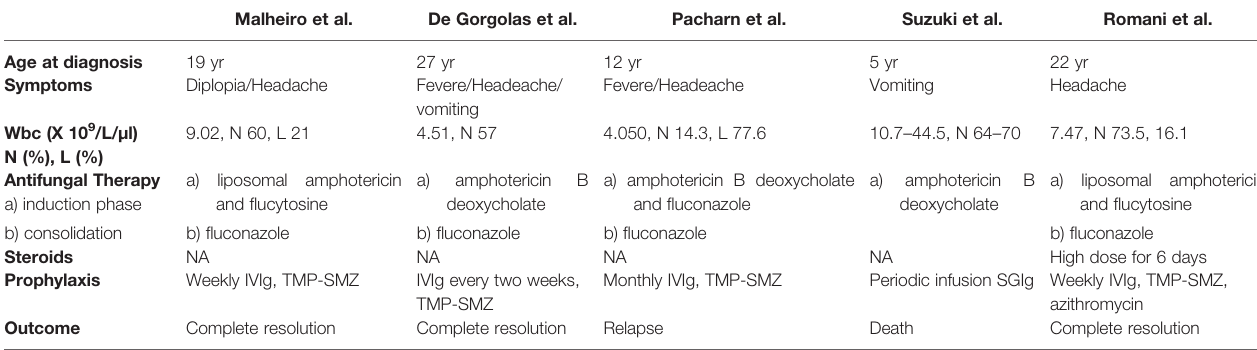
TABLE 1 | Clinical and Therapeutic fi ndings in Hyper-IgM Syndrome with CM. Malheiro et